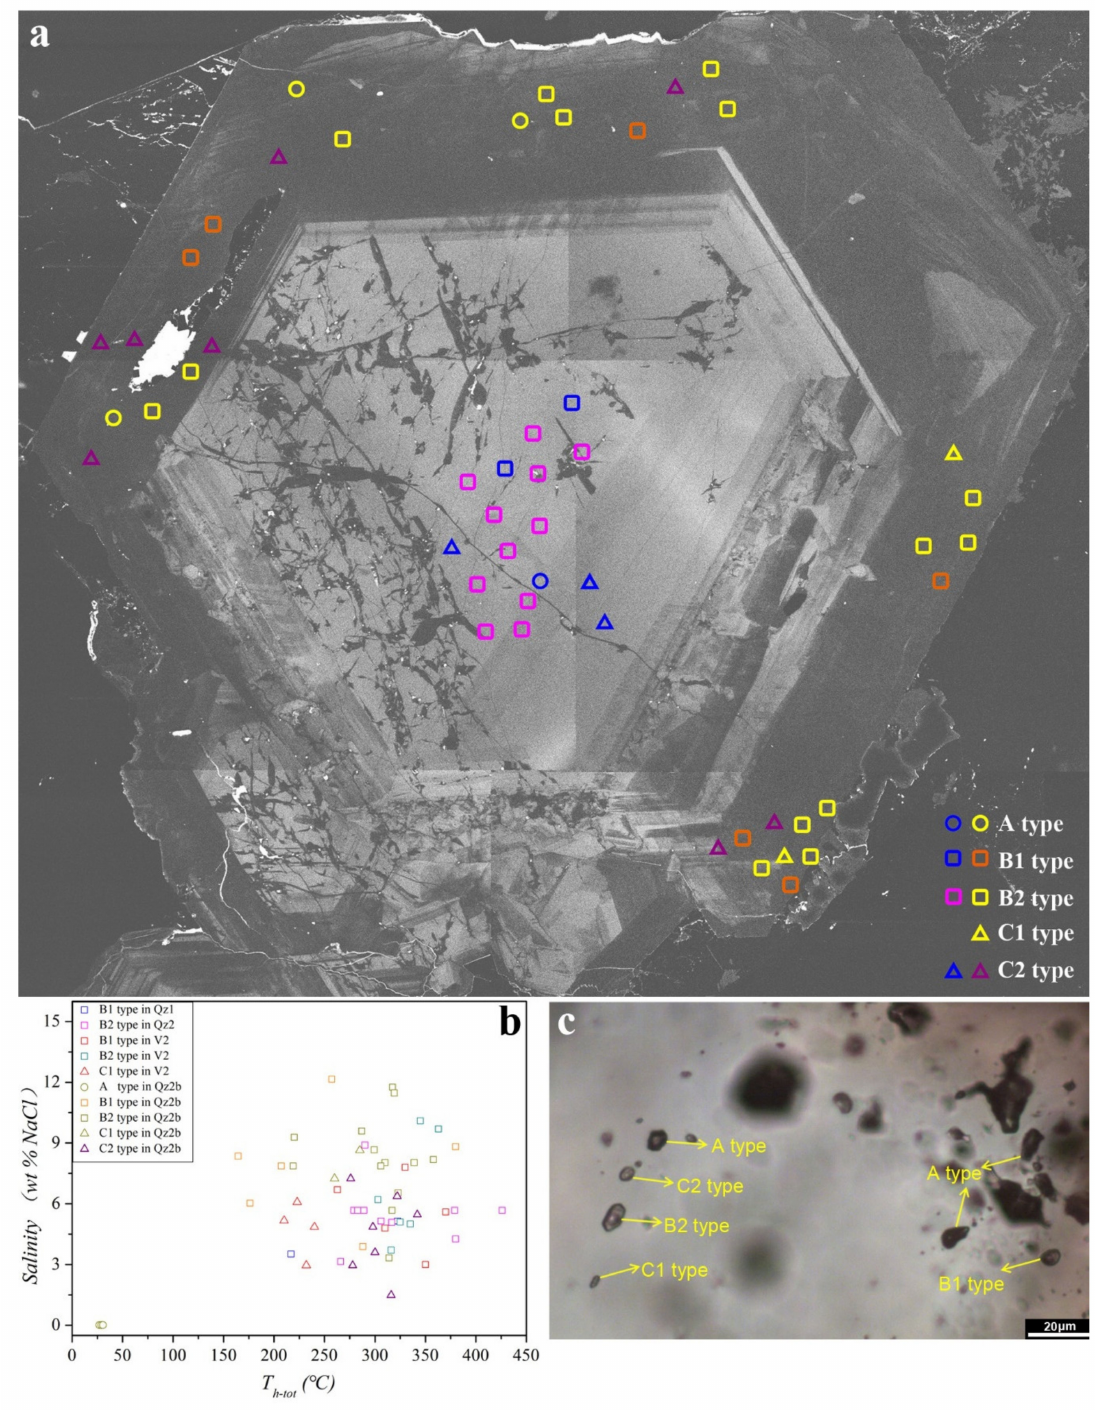
Figure 7. SEM-CL imaging of quartz with distributions of fluid inclusions ( a ) and a plot of homogenization temperatures and the salinity of di ff erent types of inclusions ( b ) revealed by CL image in ( a ). Due to a lack of Qz2a in ( a ), fluid inclusion data are from Qz2a bearing V2 veins. ( c ) Boiling fluid inclusions assemblage in